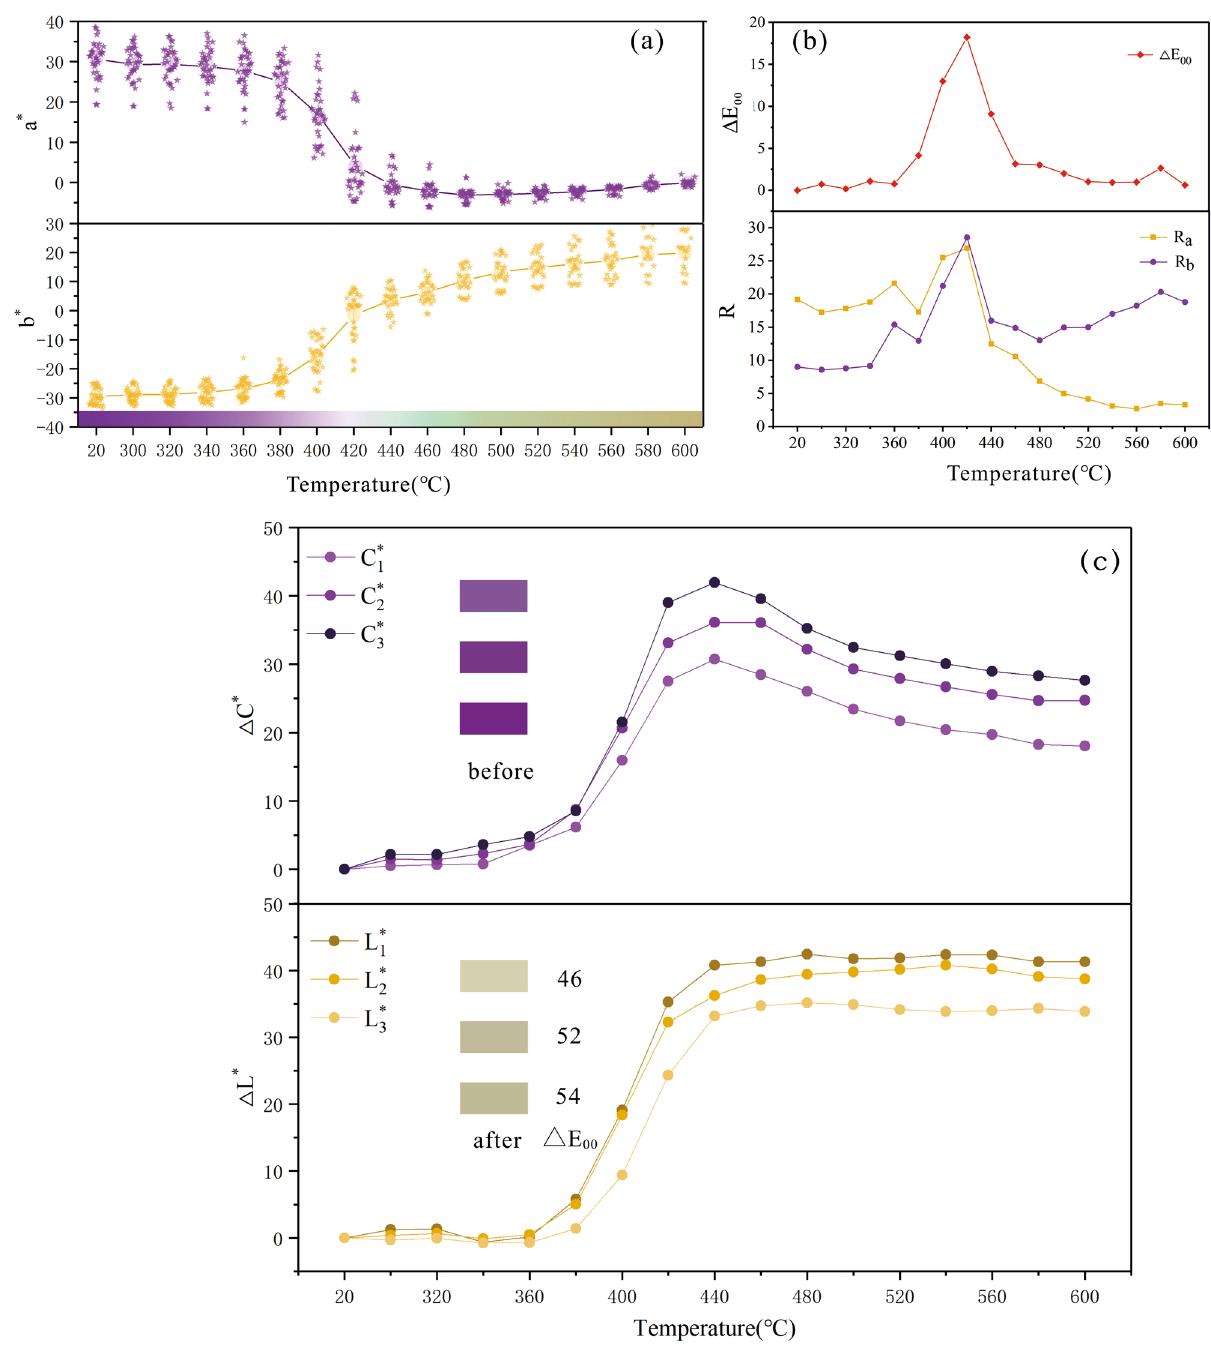
Figure 5. The change of amethyst color parameters under different heat treatment temperature. ( a ) The box plot of relationship between a*, b* value and temperature. ( b ) The relationship between R a , R b , ΔE 00 and temperature. R a , R b and ΔE 00 reach the maximum value at 420 °C. ( c ) The relationship between the degree of color change of amethyst and the initial color. ΔE 00 represents the color difference of each categories before and after heat treatment. When the initial color is darker, the amethyst color is easier to change after heat treatment. The figures were drawn using the OriginPro 2017C Beta b9.4.1.268 (https ://www.Origi nLab.com) and CorelDRAW Graphics Suite X8 2016 18.0.0.405 (https ://www.corel